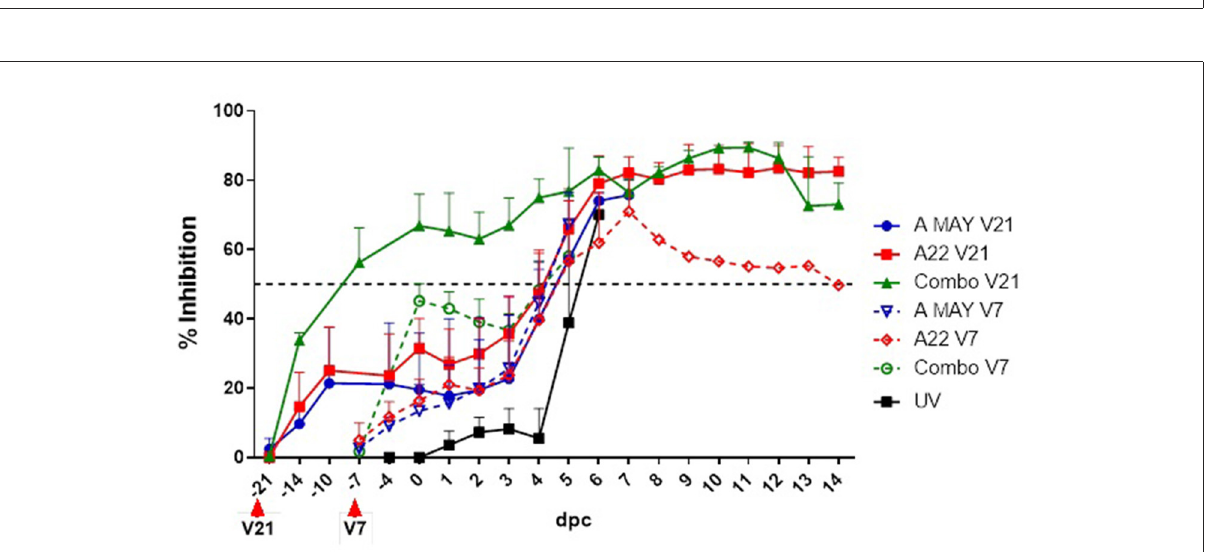
FIGURE3 Antibody responses to FMDV structural protein based on a solid-phase competition ELISA. Per cent Inhibition values are shown in the y-axis and day post-challenge (dpc) in the x-axis. The error bars represent the standard deviation of mean PI values. The horizontal dashed line indicates the cut-off level for a sample to have a positive response to vaccination. V21 and V7 indicate the day the vaccines were administered prior to the